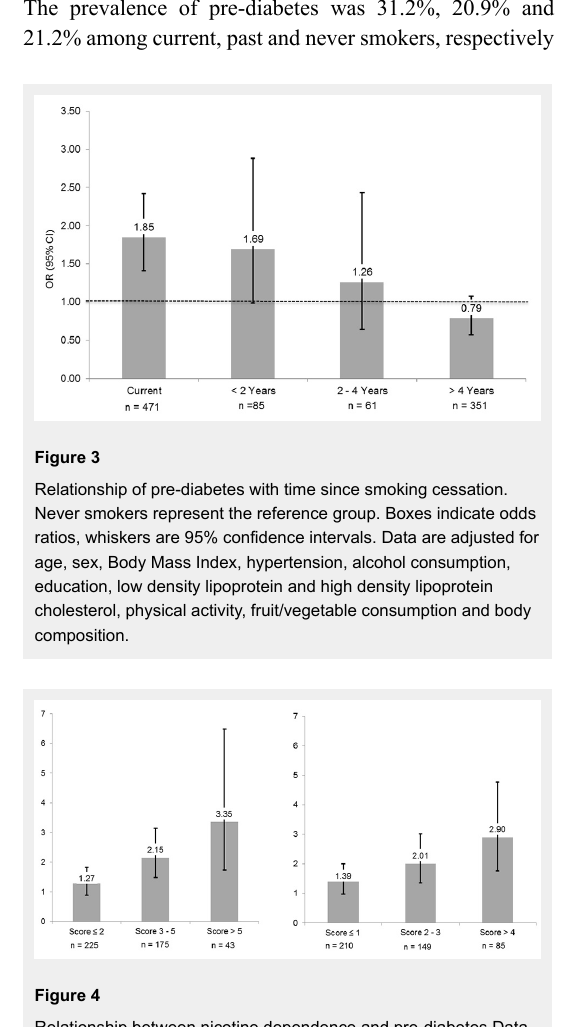
Relationship between nicotine dependence and pre-diabetes Data are with (left side) and without (right side) including information on cumulative smoking exposure into the score. Never smokers represent the reference group. Boxes indicate odds ratios, whiskers are 95% confidence intervals adjusted for age, sex, Body Mass Index, hypertension, alcohol consumption, education, low